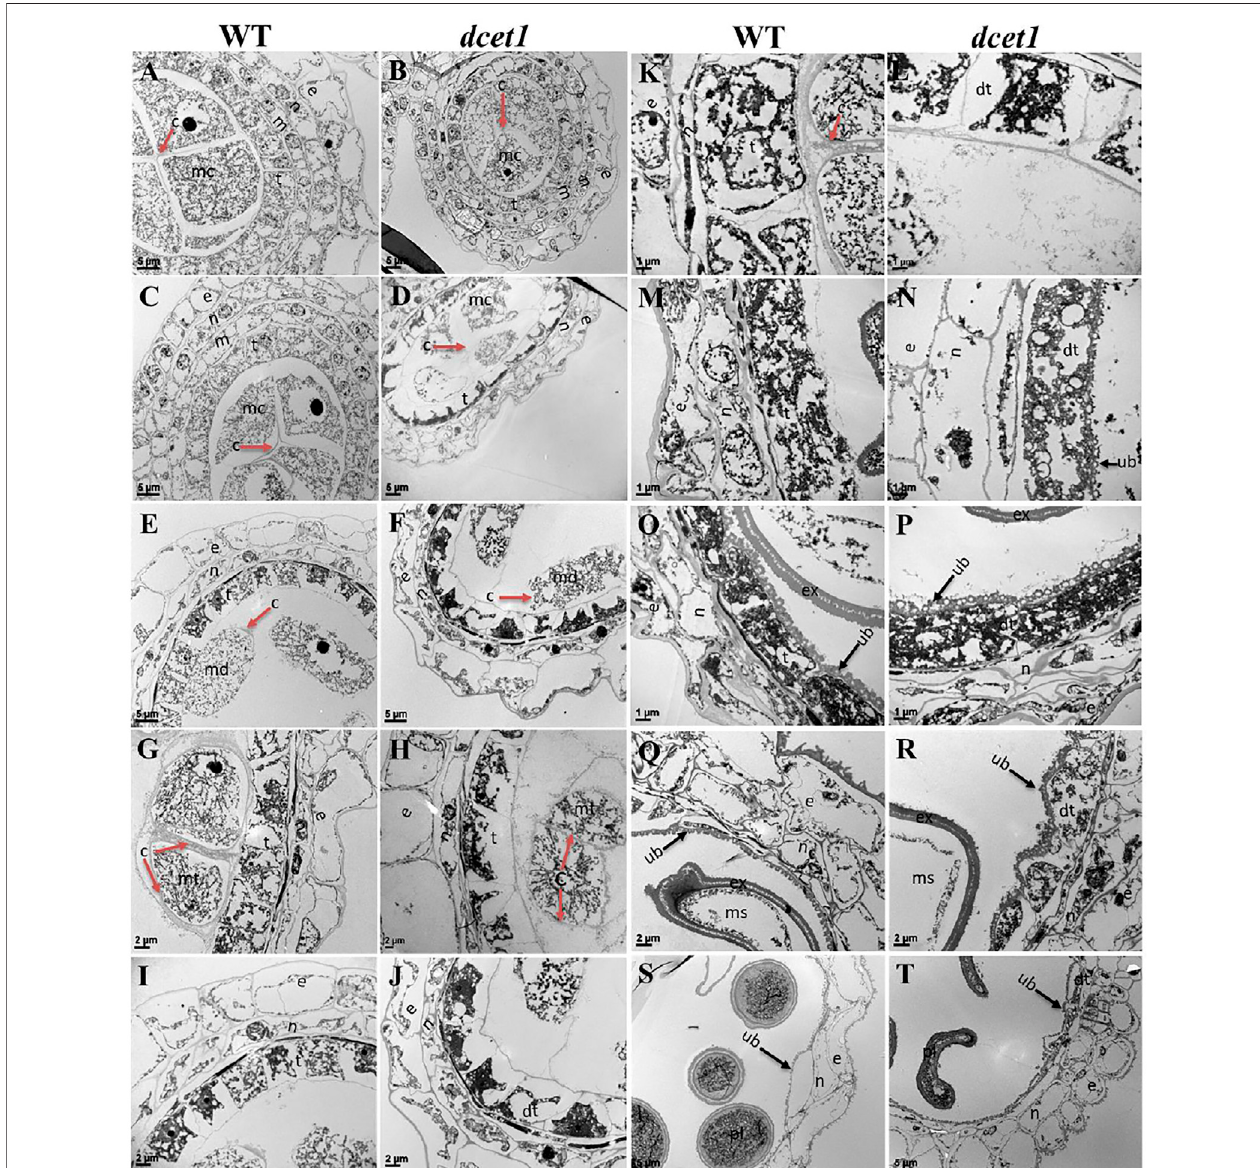
FIGURE 4 | TEM analysis of the anther callose wall and tapetum in the wild-type (WT) and mutant ( dcet1 ). Comparison of WT and dcet1 for the callose wall (A – H) ; Comparison of WT and dcet1 for the tapetum (I – T) . Red and black arrows are used for describing the callose layer and tapetum Ubisch bodies, respectively. c, callose; mc, mother cell; md, dyad; mt, tetrad; ms, microspore, dms, defective microspore; pl, pollen; dpl, defective pollen; e, epidermis ; n, endothecium; m, middle layer; t, tapetum; dt, defective tapetum; ub, Ubisch bodies. Scale bars (cid:1) 5 µm (A – F,S,T) , 2 µm (G – J,Q,R) , and 1 µm (K – P)